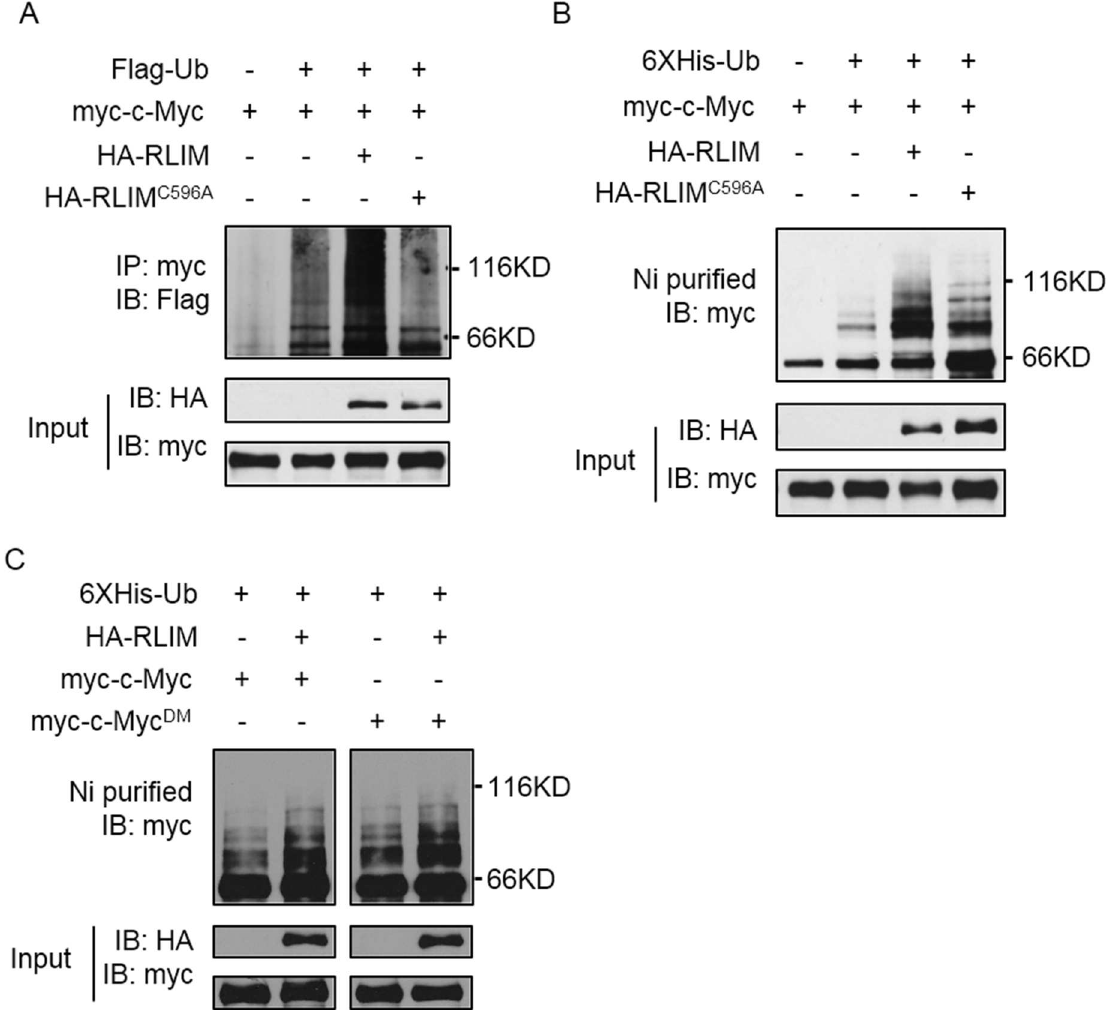
Fig 2. RLIM promotes c-Myc ubiquitination. (A) 293T cells were transfected with Flag-Ub, myc-c-Myc, HA-RLIM and HA-RLIM C596A in combinations as indicated.Ectopically expressedc-Myc was immunoprecipitated by anti-myc antibody followedby WB with anti-Flag antibody.(B) 293T cells were transfected as in (A) except using 6 × His-Ub instead of Flag-Ub. Ubiquitinated proteins were precipitatedwith nickel (Ni)-NTA beads and subjectedto WB with anti-myc antibody. (C) 293T cells were transfected with His-Ub, HA-RLIM, myc-c-Myc and myc-c-Myc DM (S62A and T58A) as indicated. Ubiquitinated proteins were precipitated with nickel (Ni)-NTA beads and subjected to WB with anti-myc